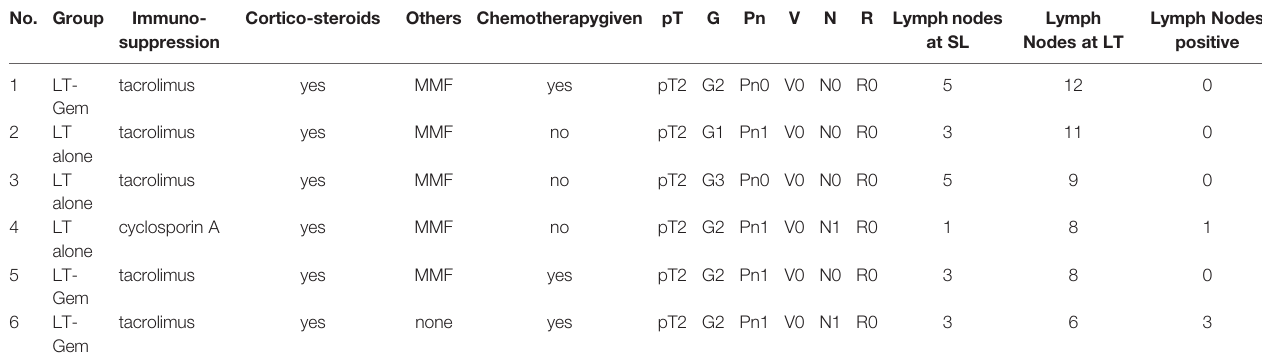
TABLE 2 | Immunosuppressive regimen and histopathological fi ndings.